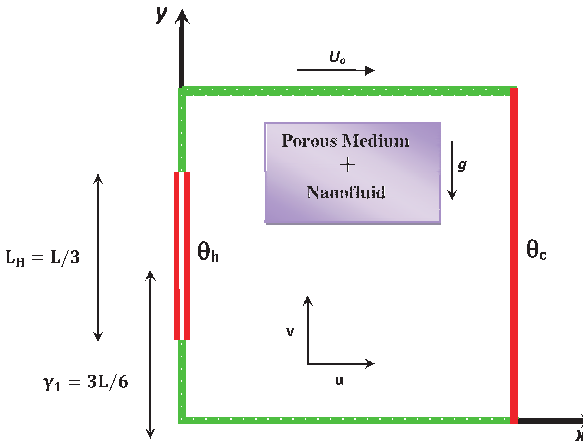
Fig. 1: A schematic view of the considered cavity in the present